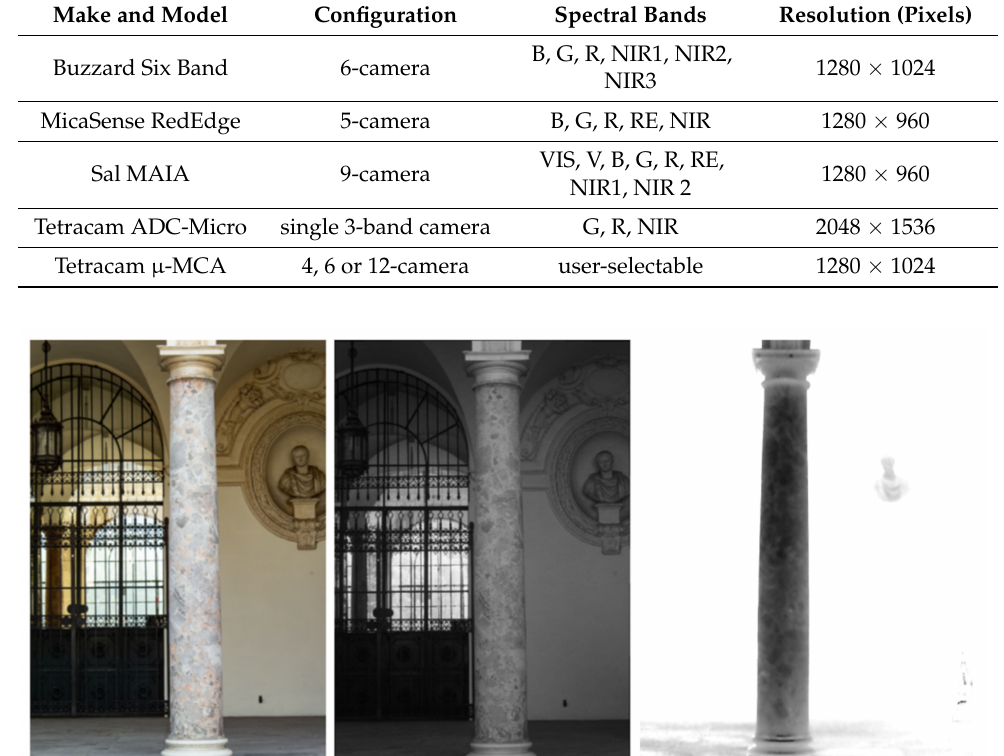
Table 3. Multispectral cameras.